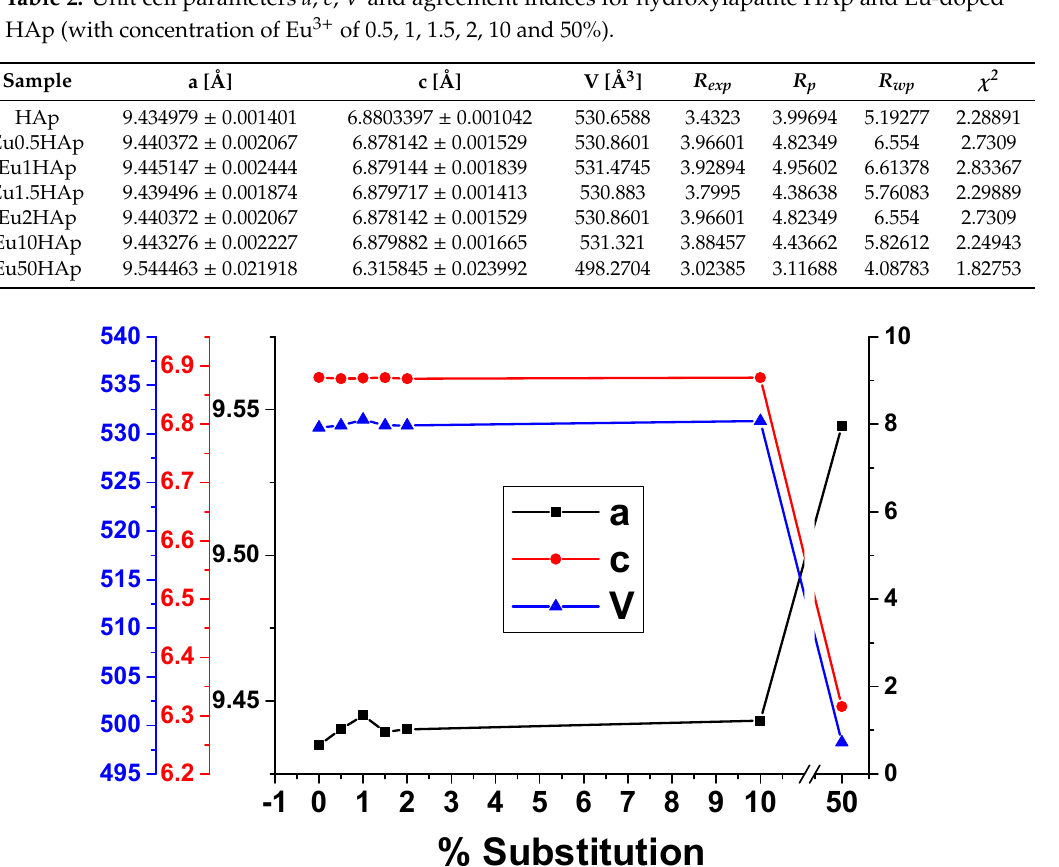
Figure 2. Unit cell parameters versus substitution degree for HAp and Eu X HAp.